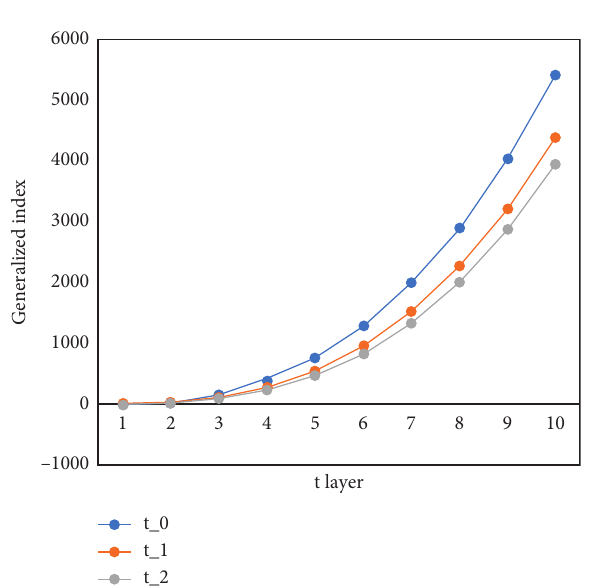
P ) using Table 1. m + S k n